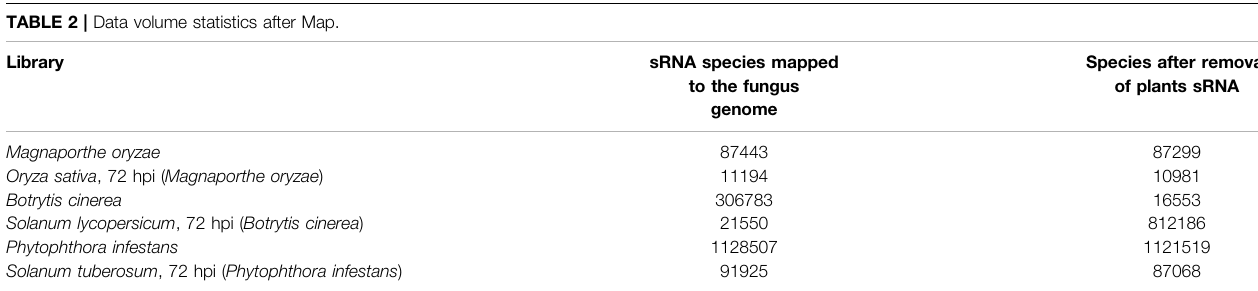
TABLE 2 | Data volume statistics after